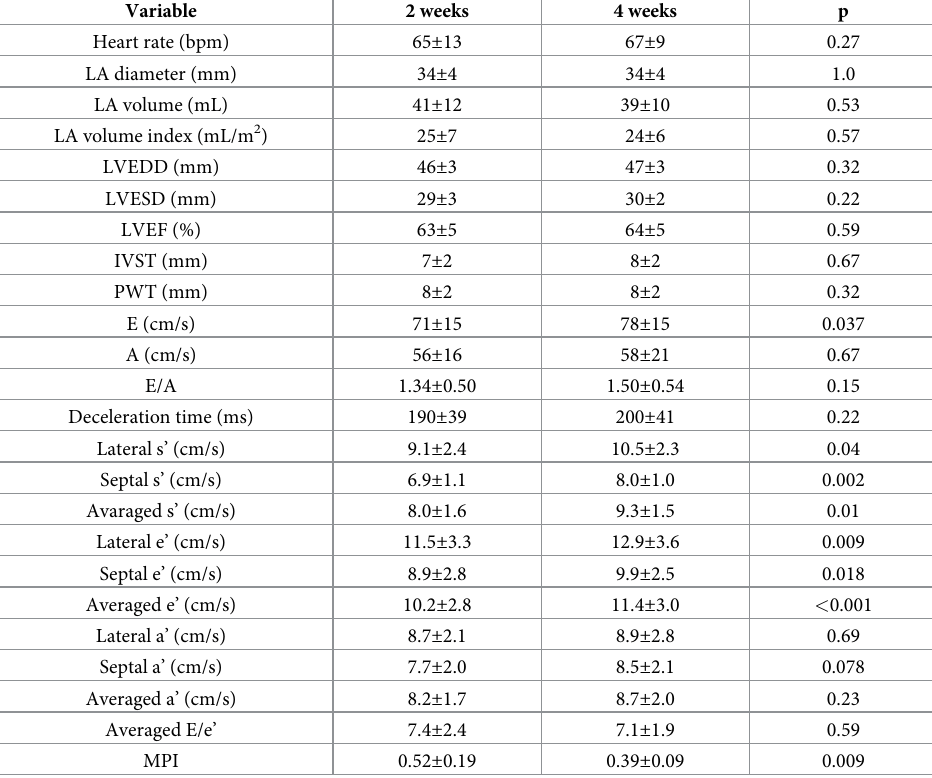
Table 3. Conventional echocardiographic parameters at 2 and 4 weeks after diagnosis of